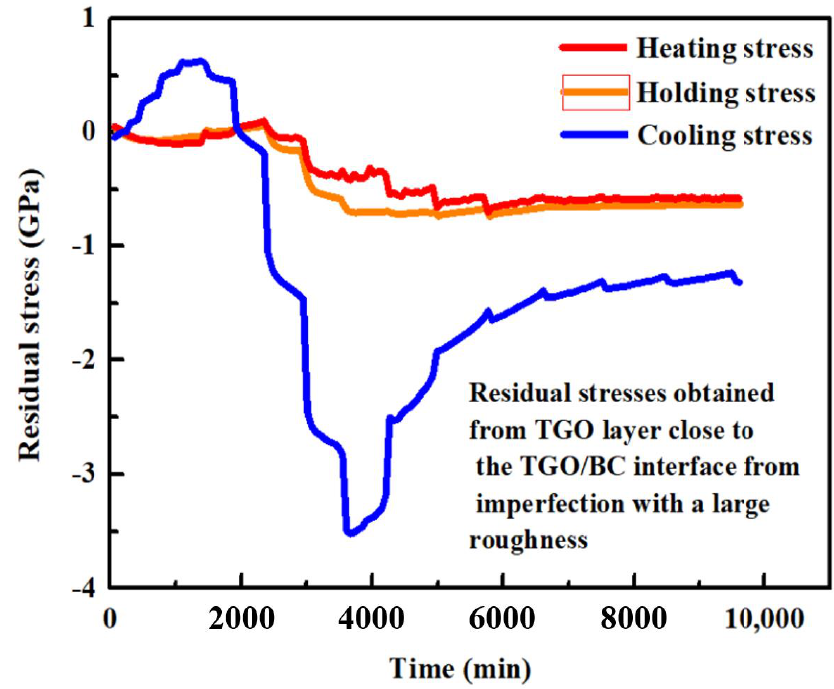
Figure 42. The maximum residual stress calculated within the TGO close to the TGO/BC interface.